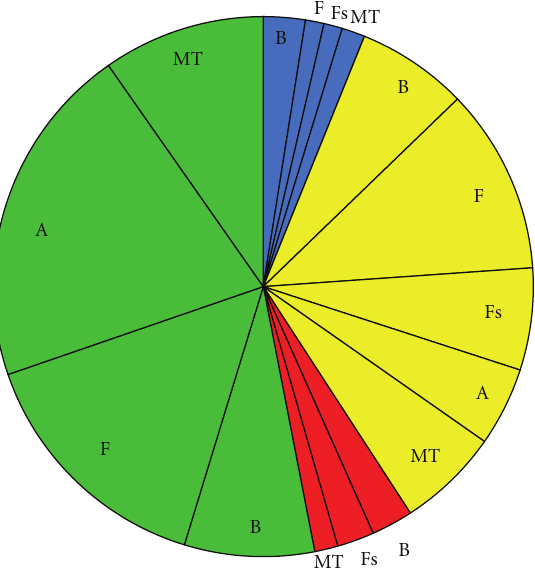
Figure 5: Pie chart representing the proportion of impacts for each ecosystem component for Impact scenario i4, bottom-mounted tidal turbine projects, categorized by whether the e ff ect is positive (blue), minor negative (green), moderate negative (yellow), or major negative (red). B = Benthic habitat and resources; F = Fish; Fs = Fisheries; A = Avian species; MT = Marine mammals and sea